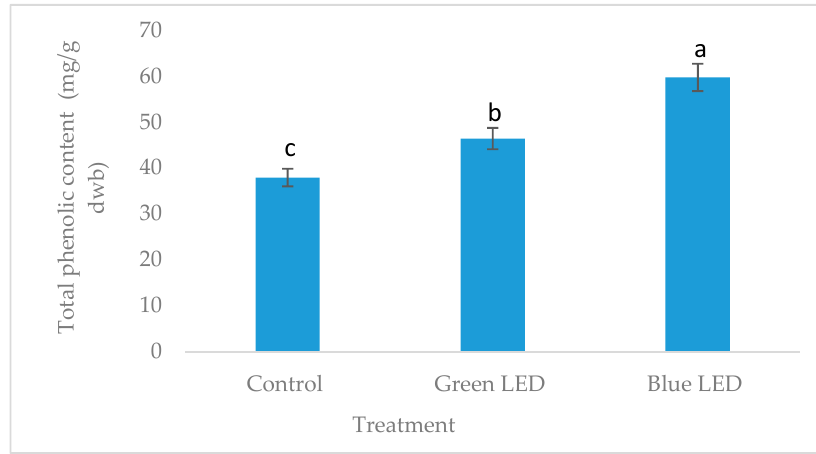
Figure 2. Total phenolic content in soybean sprouts grown under different light. Different lowercase letters within the row indicates significant differences ( p < 0.05) according to ANOVA. LED: light emitting diode.